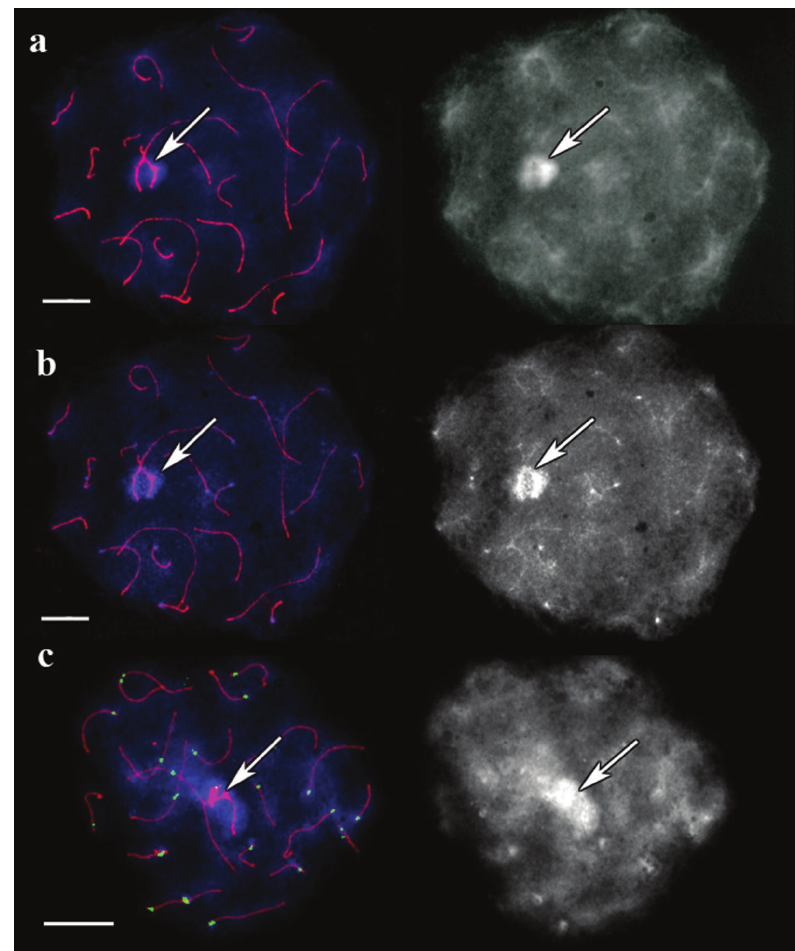
Figure 3. SC spread in pigmy shrew. a A cell after immunostaining, prior to barium hydroxide treatment . Left: Red shows SCs, and blue represents DAPI. Right: the same image, DAPI channel separately b The same cell after 5 minutes of barium hydroxide treatment. Left: Red shows SCs, and blue represents DAPI. Right: the same image, DAPI channel separately c Bright DAPI spots with their corresponding centromere signals. The cell after 5 min of barium hydroxide treatment. Left: Red, green and blue indicate SCs, centromeres, and DAPI, respectively. Right: the same image, DAPI channel separately. Arrows indicate sex bivalent. Scale bars = 20